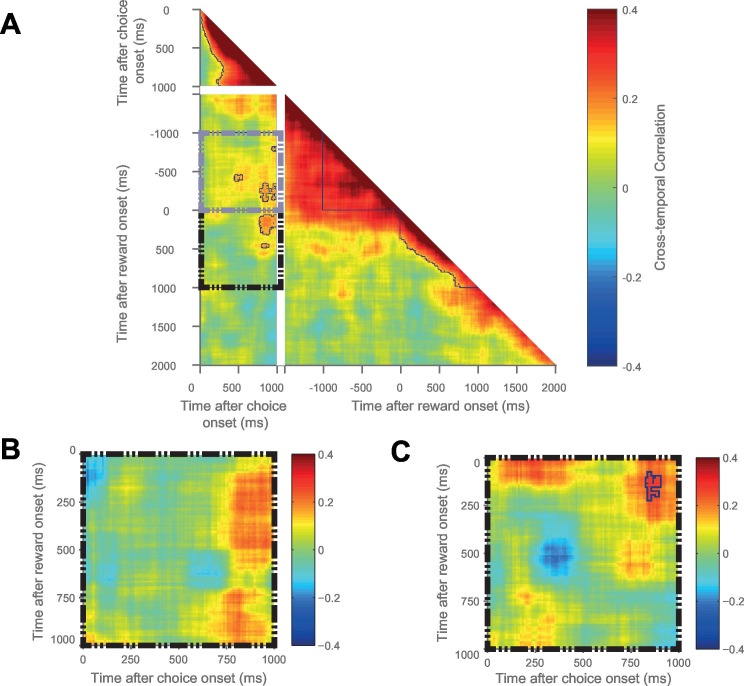
Cross-temporal analysis of DLPFC activity.Chosen value correlates are present at choice and outcome, but sustained coding between choice and outcome is absent. Blue lines indicate a significant area of cross-correlation (p<0.05, see Materials and methods). (B and C) The black dashed inset (bottom left quadrant in A) is then performed in high (B) and low (C) time constant DLPFC neurons separately. There is no sustained coding present in either high or low time constant cells; only a small cluster of reactivation coding is evident in low time constant cells (p=0.029, see Materials and methods).